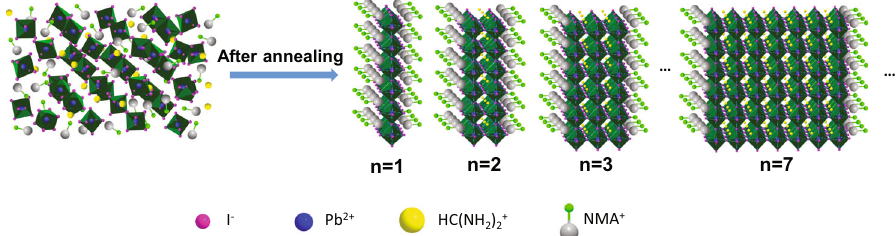
Fig. 1 Schematic representation of the evolution of perovskite MQW constitutions upon annealing. The resulted MQW perovskite is a mix of layered perovskites with different layer numbers ( n ) of lead halide